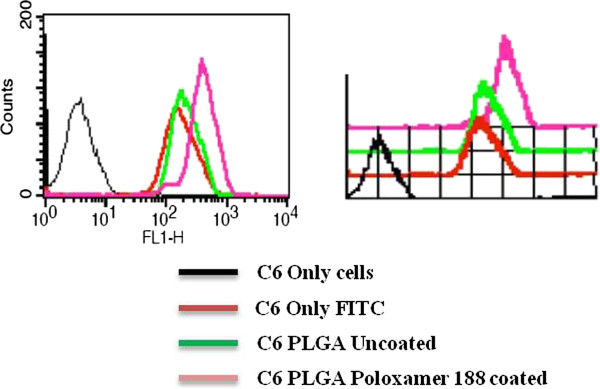
Cellular uptake using flow cytometry. Uptake of PLGA-poloxamer coated nanoparticles is higher (pink color) than the uncoated nanoparticles (green color) and cell treated with only FITC (red color). Black colour indicates background fluorescence because of only cells. Both 2D and 3D representations are shown.